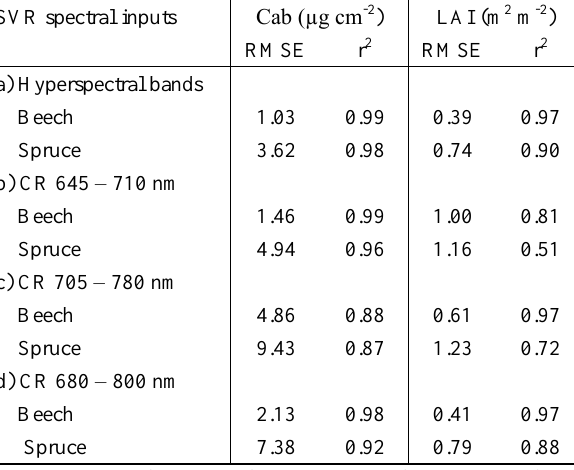
Table 3. Performance of SVR machines for retrievals of chlorophyll content (Cab) and leaf area index (LAI) using different spectral inputs (scenarios a-d) obtained from the DART-simulated reflectance look-up tables.